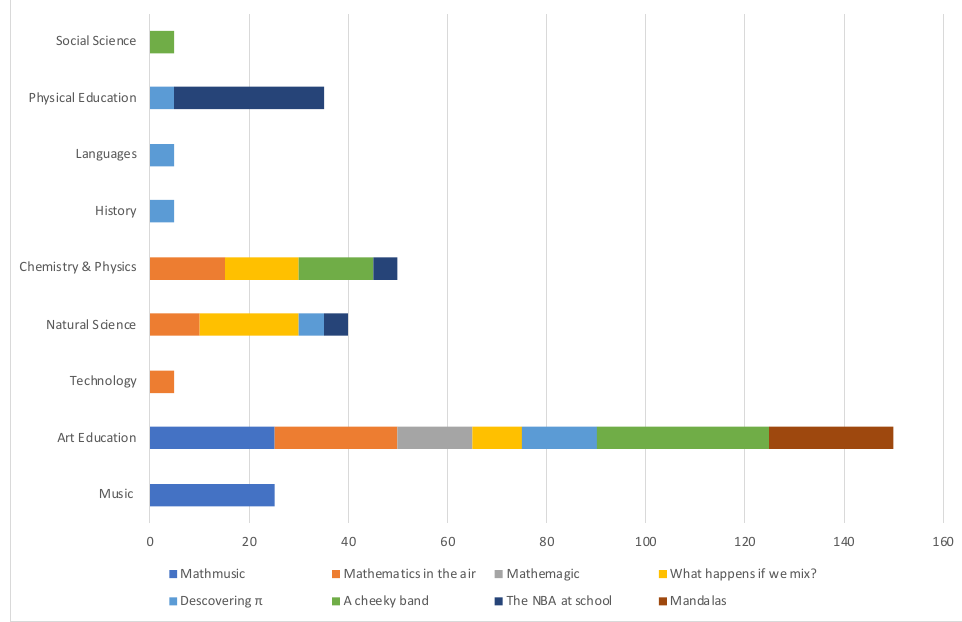
Figure 2. Interdisciplinary connections considered by future teachers.